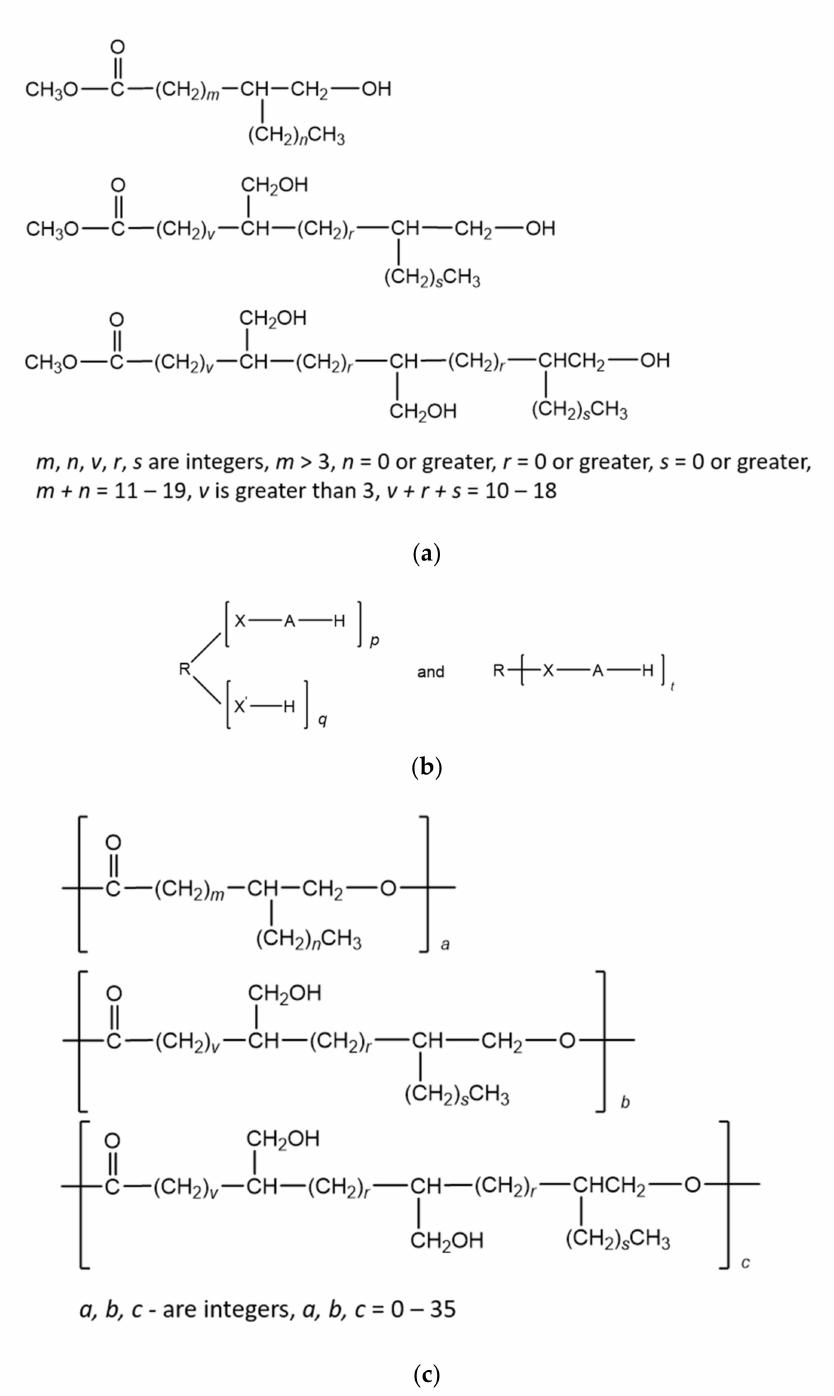
Figure 9. ( a ). The methyl esters of hydroxymethylated fatty acid (VOB monomers) used in the preparation of new polyols, where: m , n , v , r , s are integers, m > 3, n = 0 or greater, r = 0 or greater, s = 0 or greater, m + n = 11–19, v is greater than 3, v + r + s = 10–18. ( b ). Structure of vegetable oil based monomer (VOB), where R is the residue of a polyol, polyamine or amino alcohol, X and X’ can be the same or different and stand for O, N or NH, p , q = 1–5 is an integer, p + q + t = 3–8. A and A’ can be the same or different and is selected from the groups shown in the ( c ). ( c ). Structure of vegetable oil based monomer (VOB), where: a , b , c = 0–35 are integers; m , n , v , r , s , are integers; m is greater than 3; n , r and s is 0 or greater; m + n = 11–19; v is greater than 3; v + r + s is from 10 to